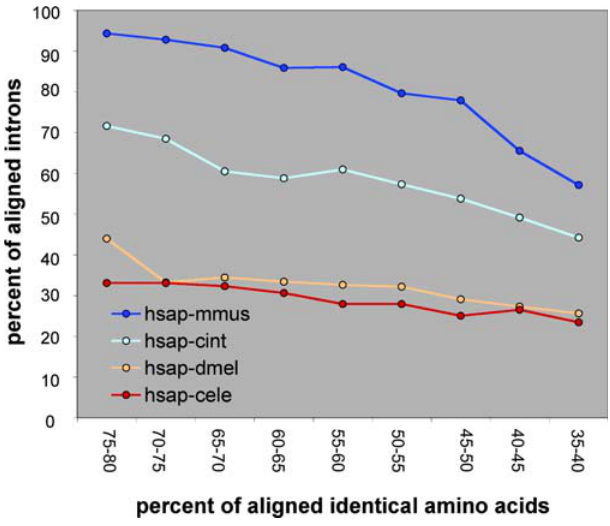
Figure 4. Intron–Exon Structures Evolve Largely Independently of Protein Sequences x -axis, human reciprocal best-hit best HSPs for four representative proteomes binned by percent identity in 5% increments. y -axis, percent of aligned introns among the HSPs in each bin. cele, C. elegans; cint, C. intestinalis; dmel, D. melanogaster; hsap, H. sapiens; mmus, M. musculus . DOI: 10.1371/journal.pcbi.0020015.g004